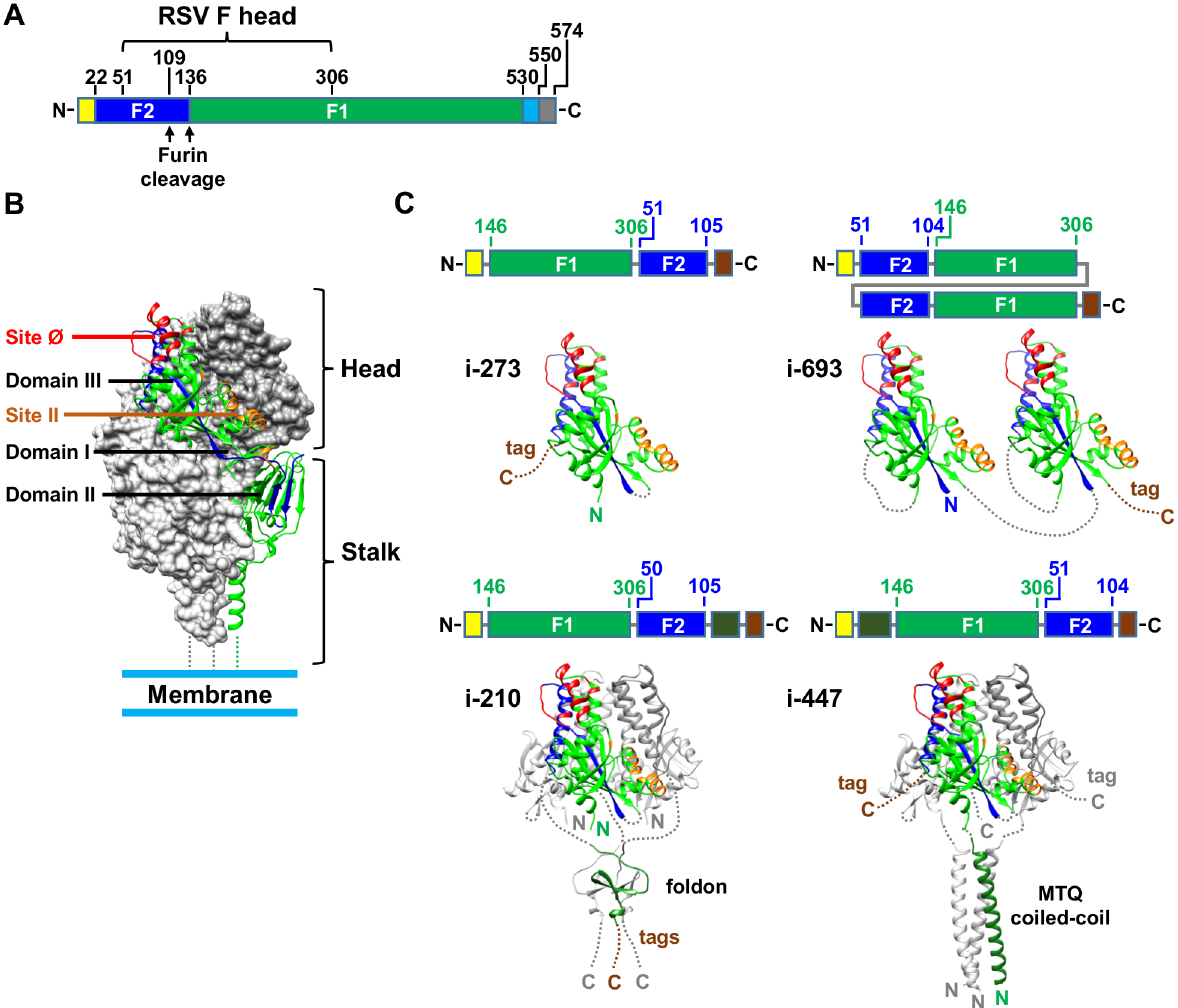
Fig 1. Design of RSV F head-only immunogens. (A) Genetic construct of RSV F illustrating the location of the head region. The signal peptide is colored yellow, F 2 is colored blue, F 1 is colored green, the transmembrane region is colored cyan and the cytoplasmic domain is colored gray. (B) Pre-F form of the RSV F trimer. One protomer of RSV F is depicted as a ribbon diagram and colored as in A. The other two protomers are gray surface representations. Antigenic site Ø and site II are red and orange respectively. Domains I, II and III are labeled as defined previously [9, 35]. (C) Models of head-only immunogens i-273, i-693 (upper panels), i-210 and i-447 (lower panels). For each immunogen a cartoon of the genetic construct is depicted (top) and a ribbon diagram (bottom), color-coded as in A and B with brown coloring for purification tags. PDB entries 4JHW [9], 1RFO [36] and 1GCM [37] were used to depict RSV F, the foldon and the coiled coil respectively. RSV F residue numbering follows the numbering in PDB entry 4JHW